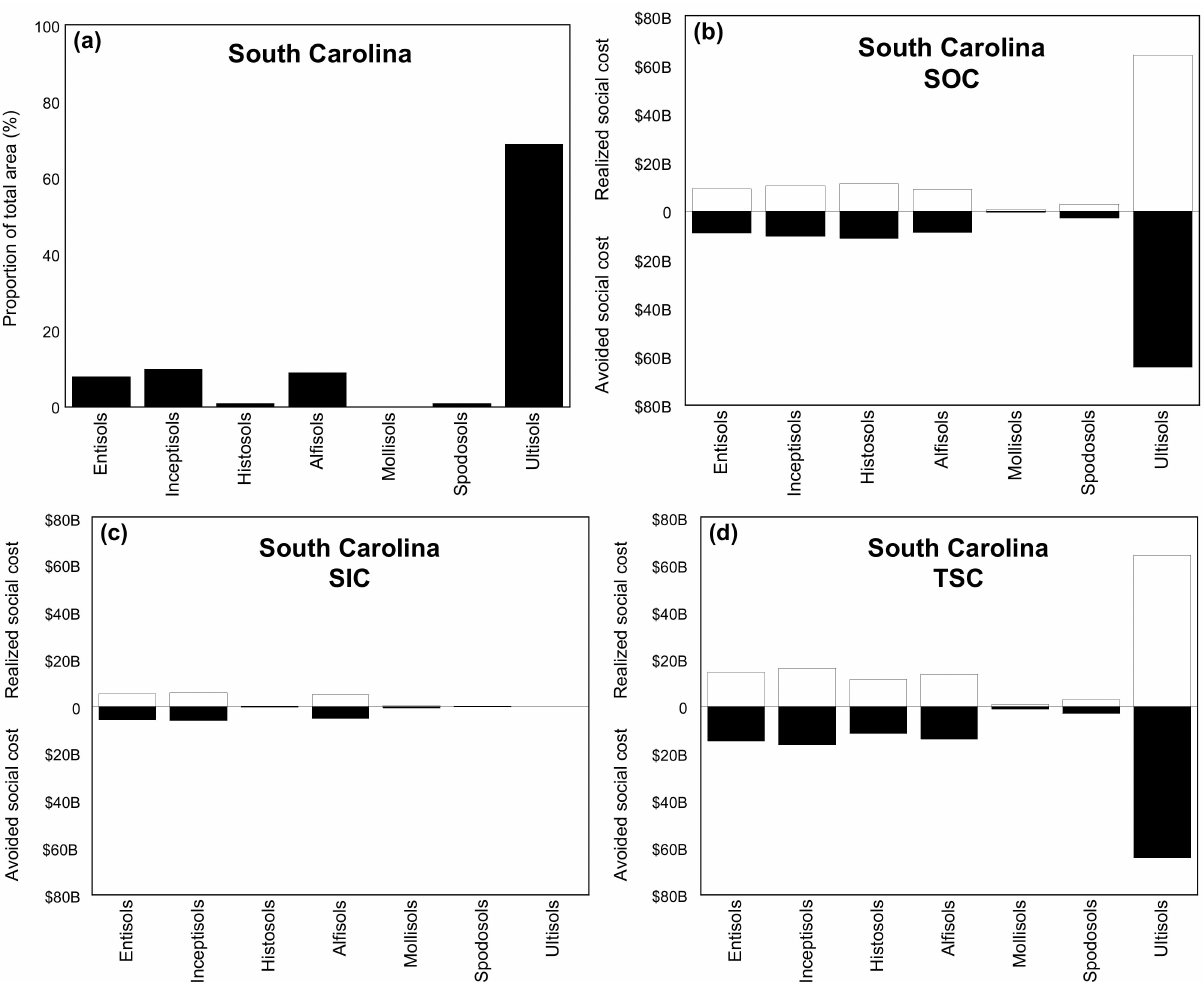
Figure 4. Diagram showing how the “portfolio-effect” and “distribution-effect” of pedodiversity can vary within the state: ( a ) pedodiversity by soil order area; ( b ) value of soil organic carbon (SOC) storage, ( c ) value of soil inorganic carbon (SIC) storage, ( d ) value of total soil carbon (TSC) storage in the upper 2-m depth based on avoided or realized the social cost of CO 2 (SC-CO 2 ) of $46 (USD) per metric ton of CO 2 [17] by soil order. Note: B = billion = 10 9 . Soil “portfolio” differs within each county, and Figure 5 illustrates this concept using three counties from different regions: Anderson (Upstate), Newberry (Midlands), and Colleton (Low